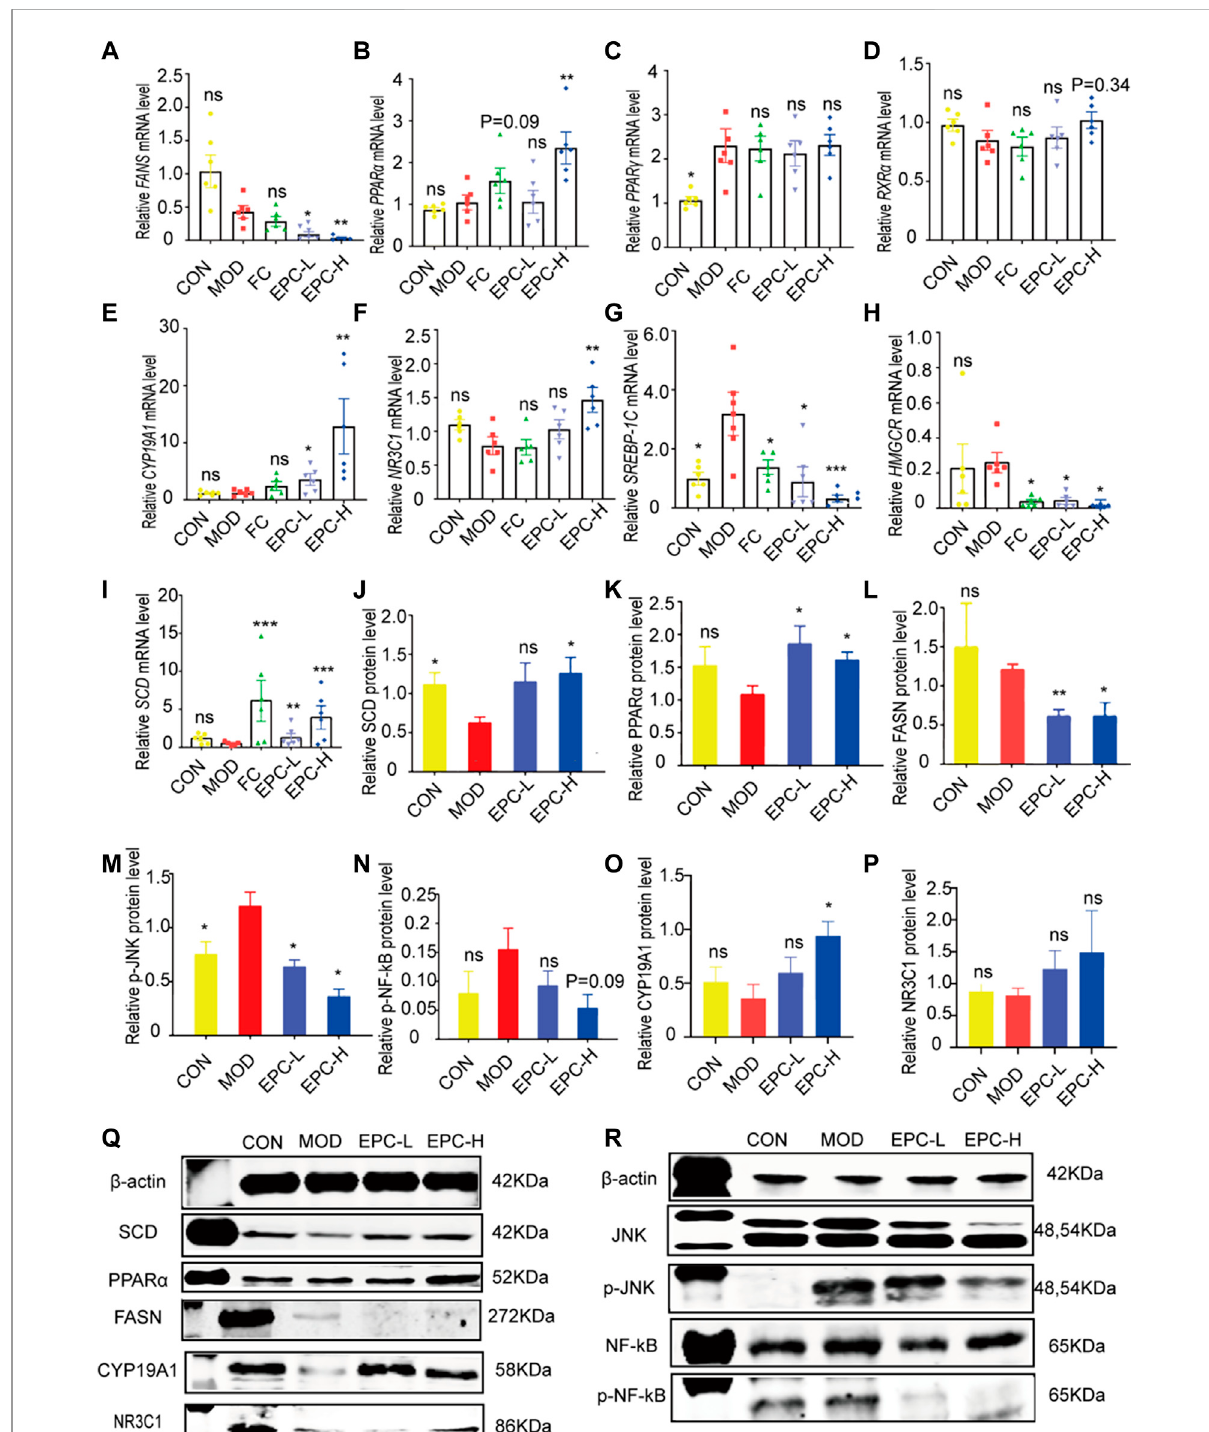
EPC regulated the lipid metabolism-related genes and proteins inMAFLD rats. (A) mRNA abundances of FASN . (B) mRNA abundances of PPAR α (PPARA) . (C) mRNA abundances of PPAR γ (PPARG) . (D) mRNA abundances of RXR α . (E) mRNA abundances of CYP19A1 . (F) mRNA abundances of NR3C1 . (G) mRNA abundances of SREBP-1c . (H) mRNA abundances of HMGCR . (I) mRNA abundances of SCD. n = 6; (J) Relative expression of protein SCD. (K) Relative expression of protein PPAR α . (L) Relative expression of protein FASN. (M) Relative expression of protein p-JNK. (N) Relative expression of protein p-NF- κ B. (O) Relative expression of protein CYP19A1. (P) Relative expression of protein NR3C1. (Q-R) Representative immunoblottingimagesof β -actin,SCD,PPAR α ,FASN,CYP19A1,NR3C1,JNK,p-JNK,NF- κ B,pNF- κ B; n